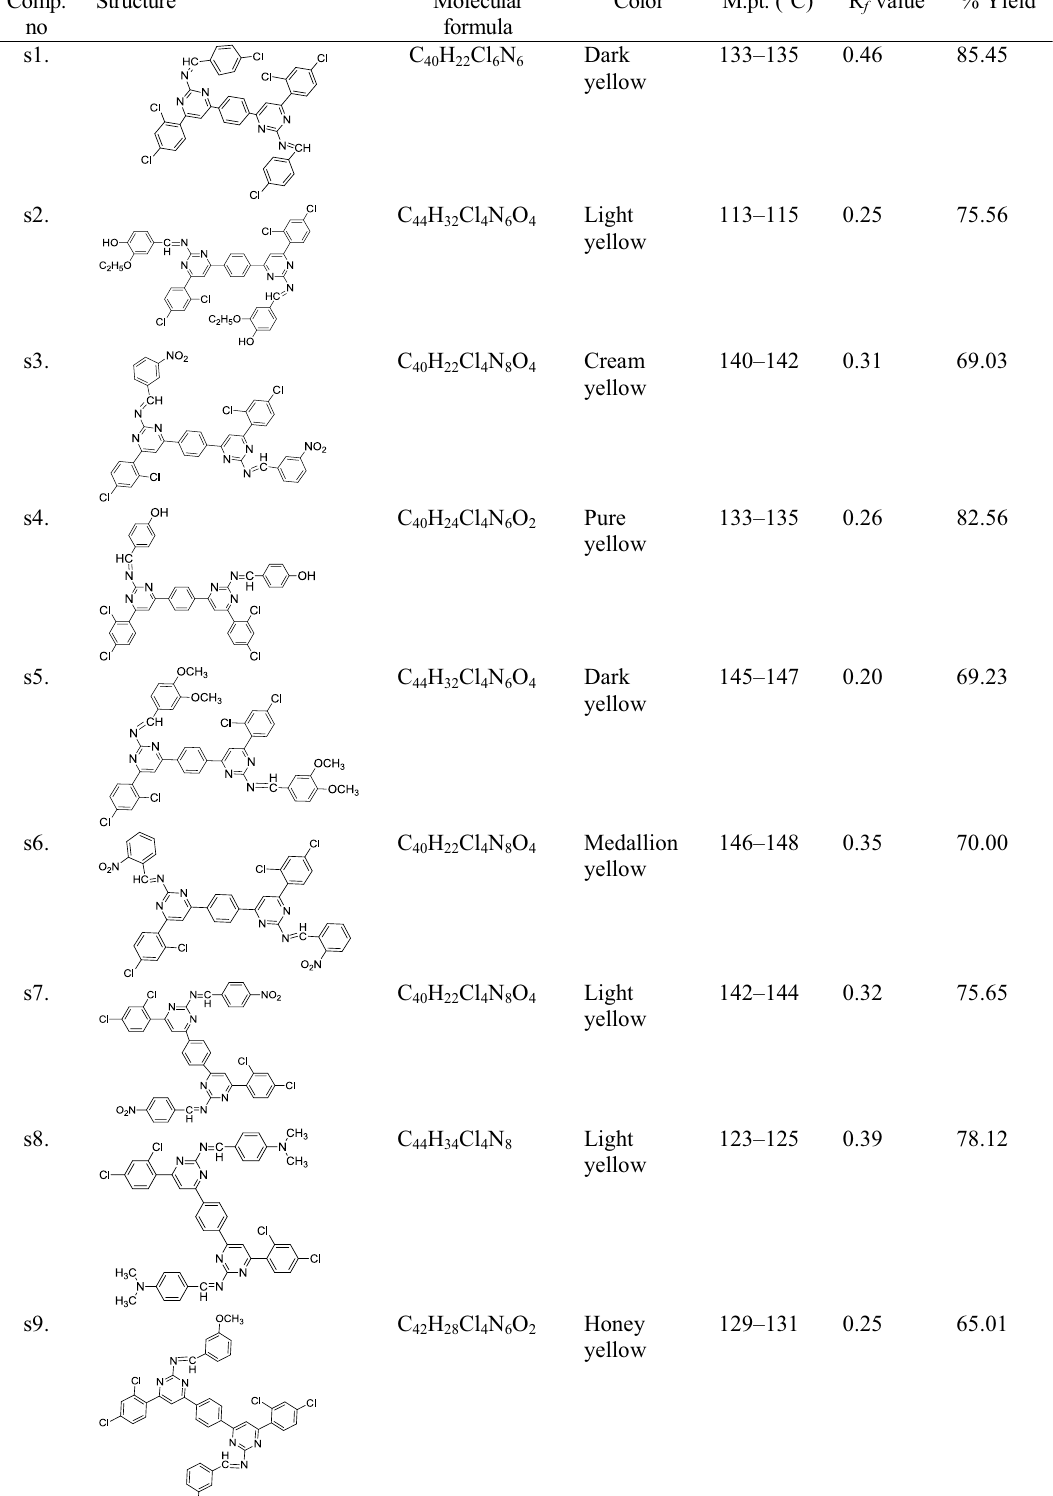
Table 1 Physicochemical properties of the synthesized bis-pyrimidine molecules